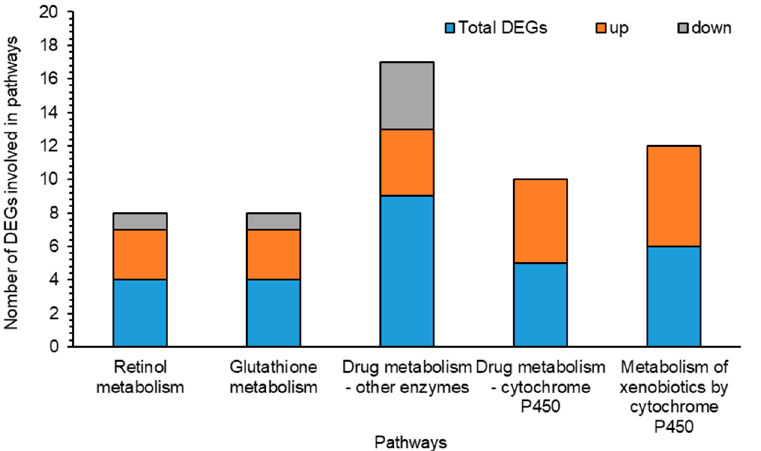
Figure 6. Comparison of up- and down-regulated genes of differentially expressed genes (DEGs) involved in different pathways of Spodoptera frugiperda after exposure of its larvae to a sublethal concentration of Noposion Yihaogong ® 5% EC insecticide versus the unselected group (CK). The x -axis lists the major detoxification pathways’ terms under categories of retinol metabolism, glutathione metabolism and drug metabolism by other enzymes, drug metabolism by cytochrome P450 and metabolism of xenobiotics by cytochrome P450. The y -axis is the number of DEGs involved in each pathway under Noposion Yihaogong ® 5% EC insecticide stress.